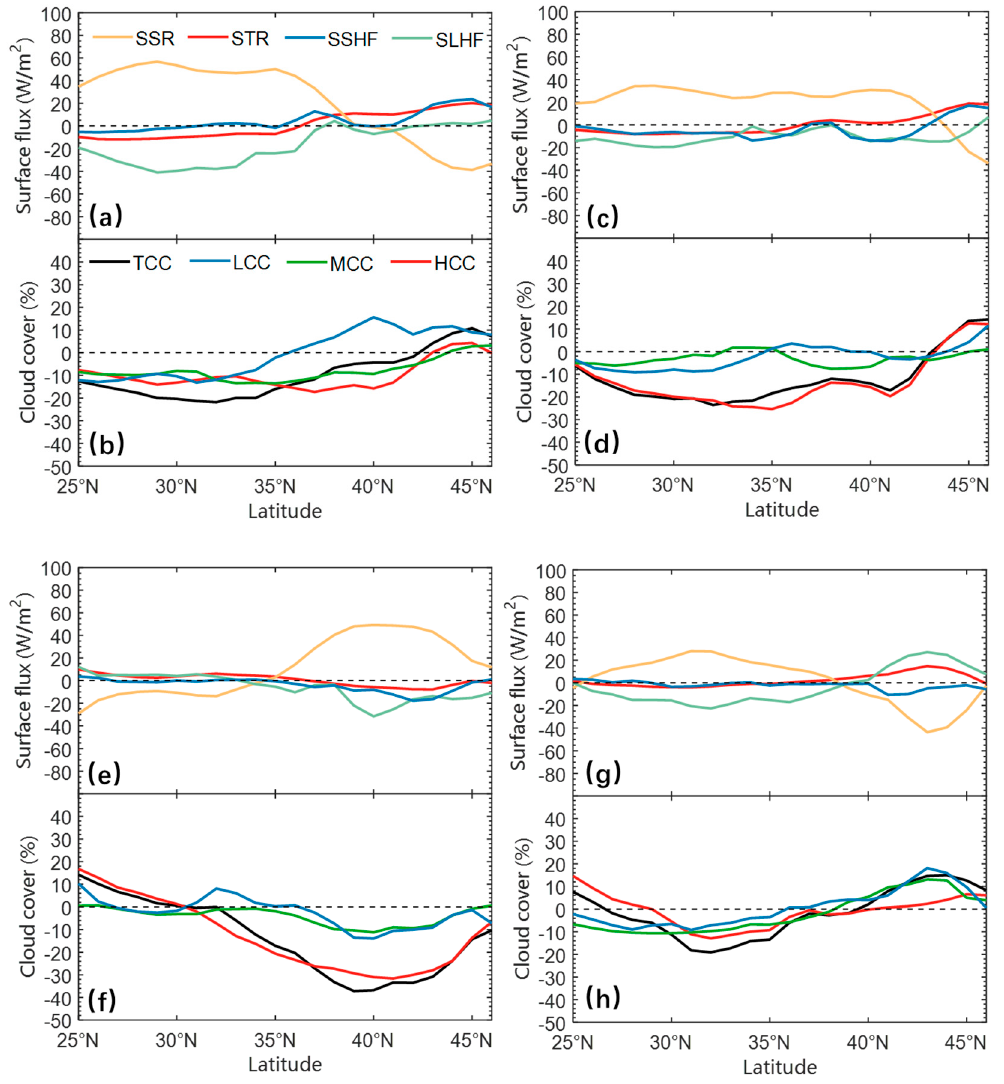
Figure 7. Zonally averaged surface solar radiation (SSR, yellow line), surface thermal radiation (STR, red line), surface sensible heat flux (SSHF, blue line) and surface latent heat flux (SLHF, green line) anomalies in region B for ( a ) hot period 1, ( c ) hot period 2, ( e ) hot period 3 and ( g ) hot period 4. Additionally, zonally averaged total cloud cover (TCC, black line), low cloud cover (LCC, blue line), medium cloud cover (MCC, green line) and high cloud cover (HCC, red line) anomalies in region B are shown in ( b ), ( d ), ( f ) and ( h ) for hot periods 1–4.